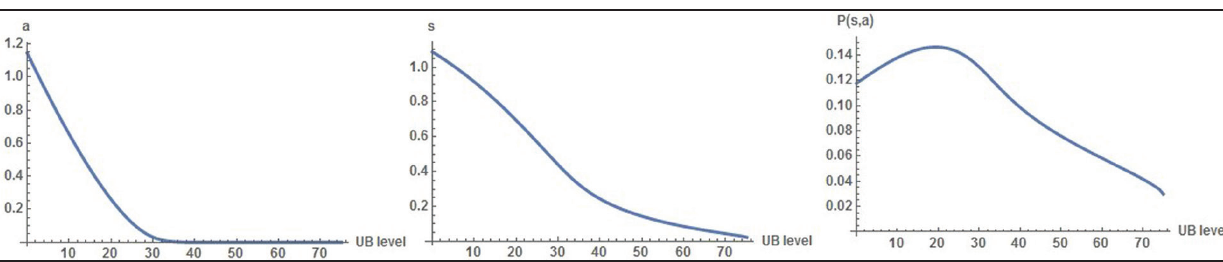
Figure 1 Baseline model [BM]. The three graphs show the level of a , s , and P ( s , a ), respectively, in the [BM] for different values of b . The functions and parameters are those of Table